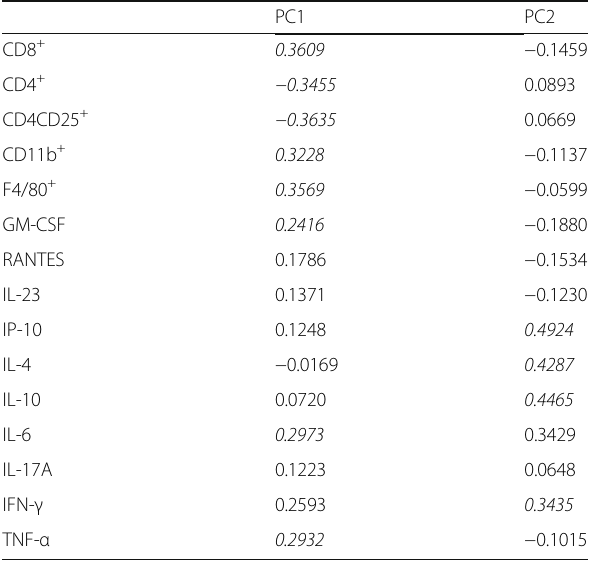
Table 3 PCA loadings relative to the first two principal components from WAT immunological profiles of MBC, LGG, and CTRL